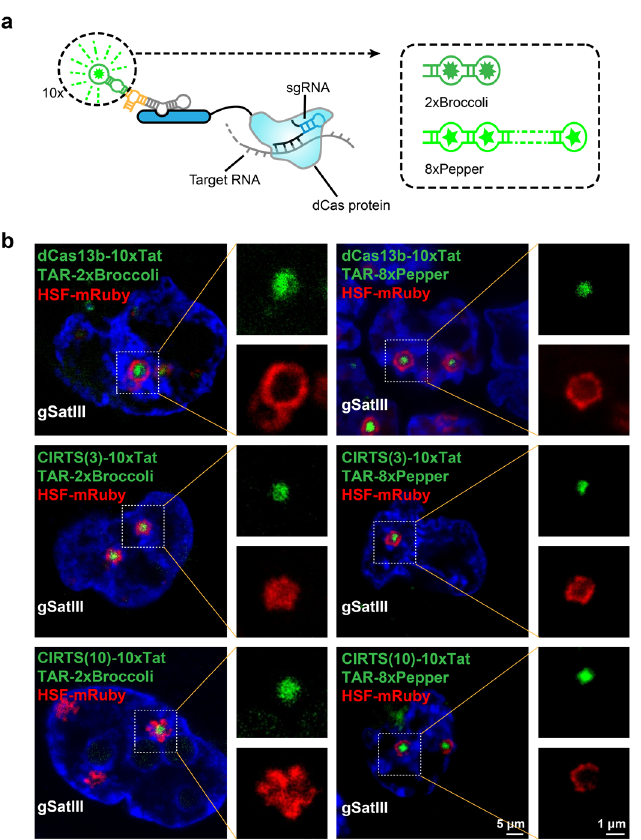
Figure 6. CRISPR-TRAP-tag systems with multiplex RNA aptamers. ( a ) Diagram of the strategy for CRISPR-TRAP-tag systems with multiplex RNA aptamers. ( b ) Representative images of SatIII labeled using CRISPR-TRAP-tag, with multiplex RNA aptamers with gRNAs.